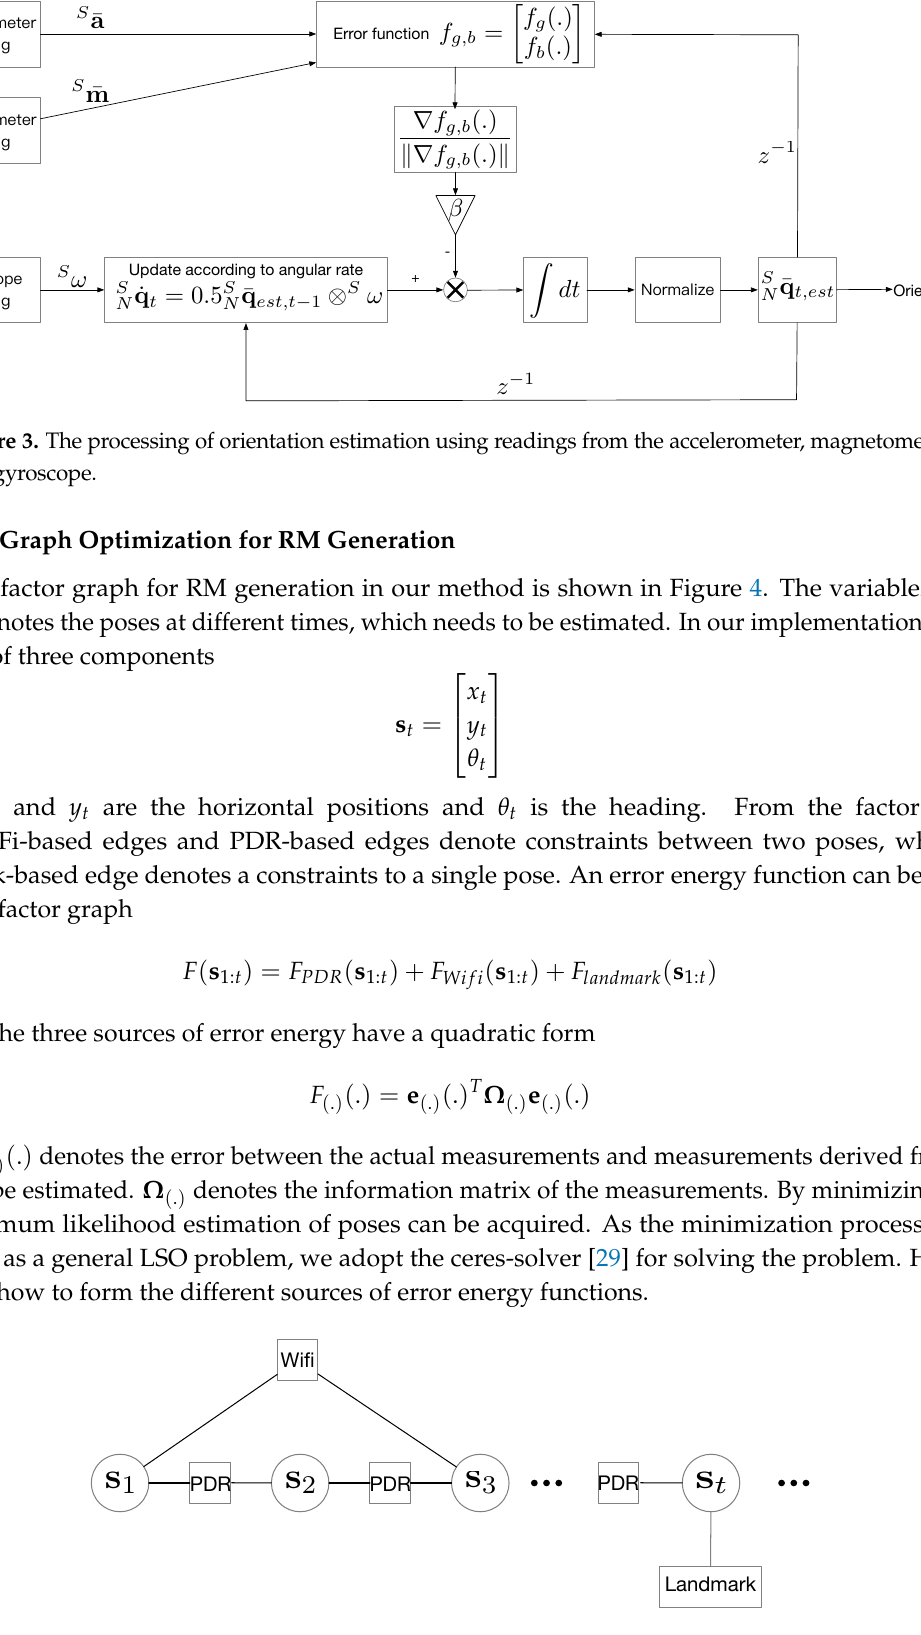
Figure 4. An illustration of the factor graph for RM generation. There are three types of edges: Wi-Fi-based edges, PDR-based edges and landmark-based